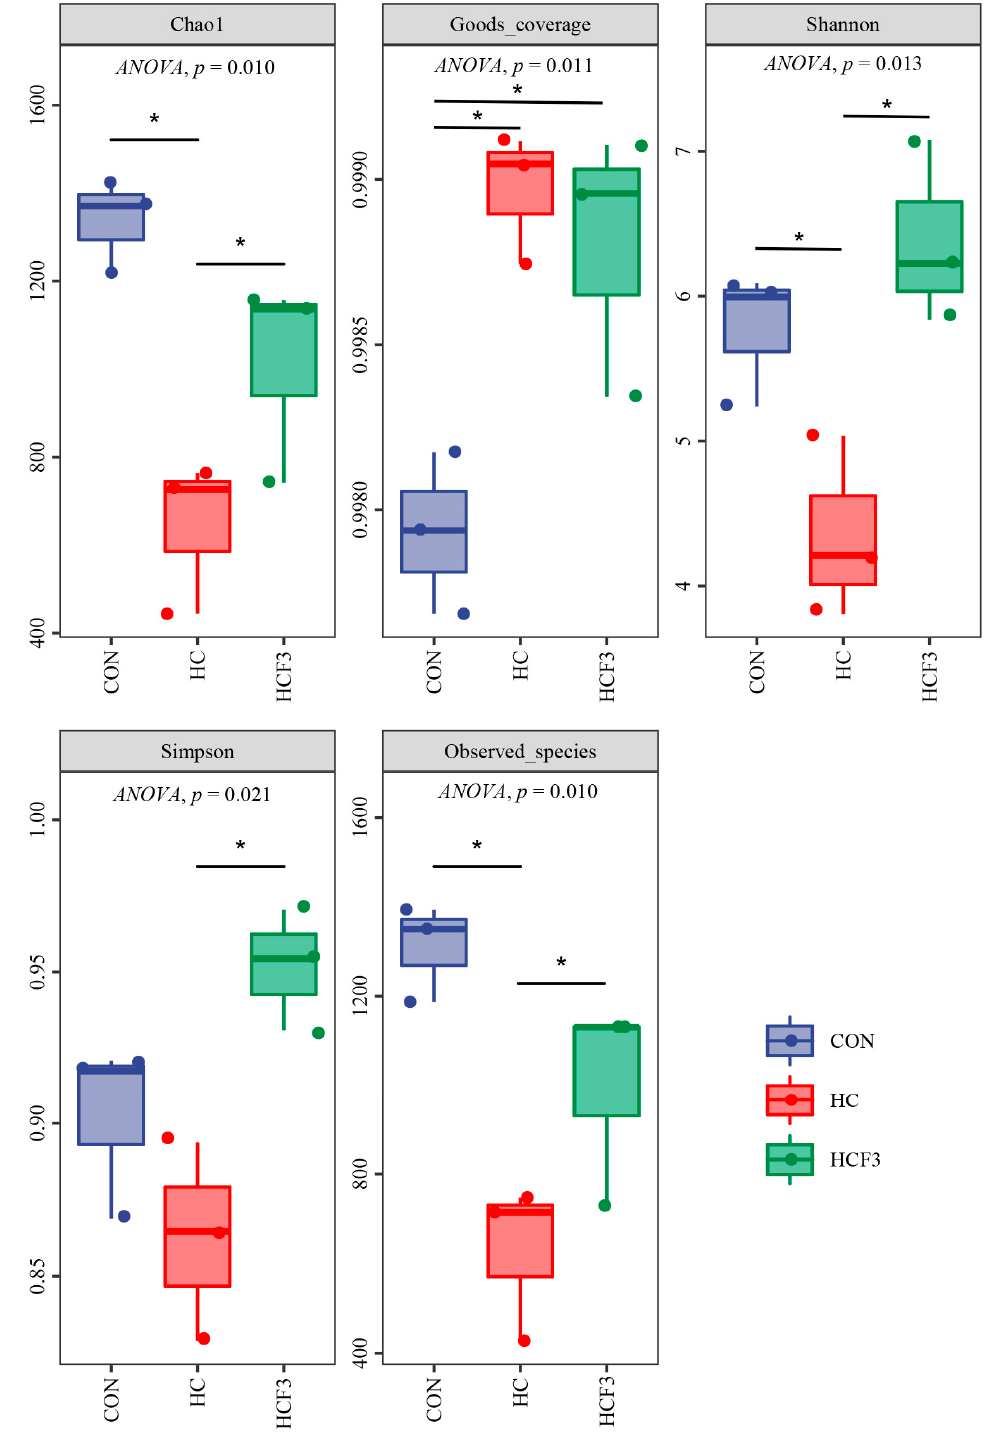
Figure 7. Influences of dietary mulberry leaf flavonoids on the alpha-diversity of intestinal microbiota in rice field eel fed a high-carbohydrate diet. * indicates a significant difference between groups ( p < 0.05).